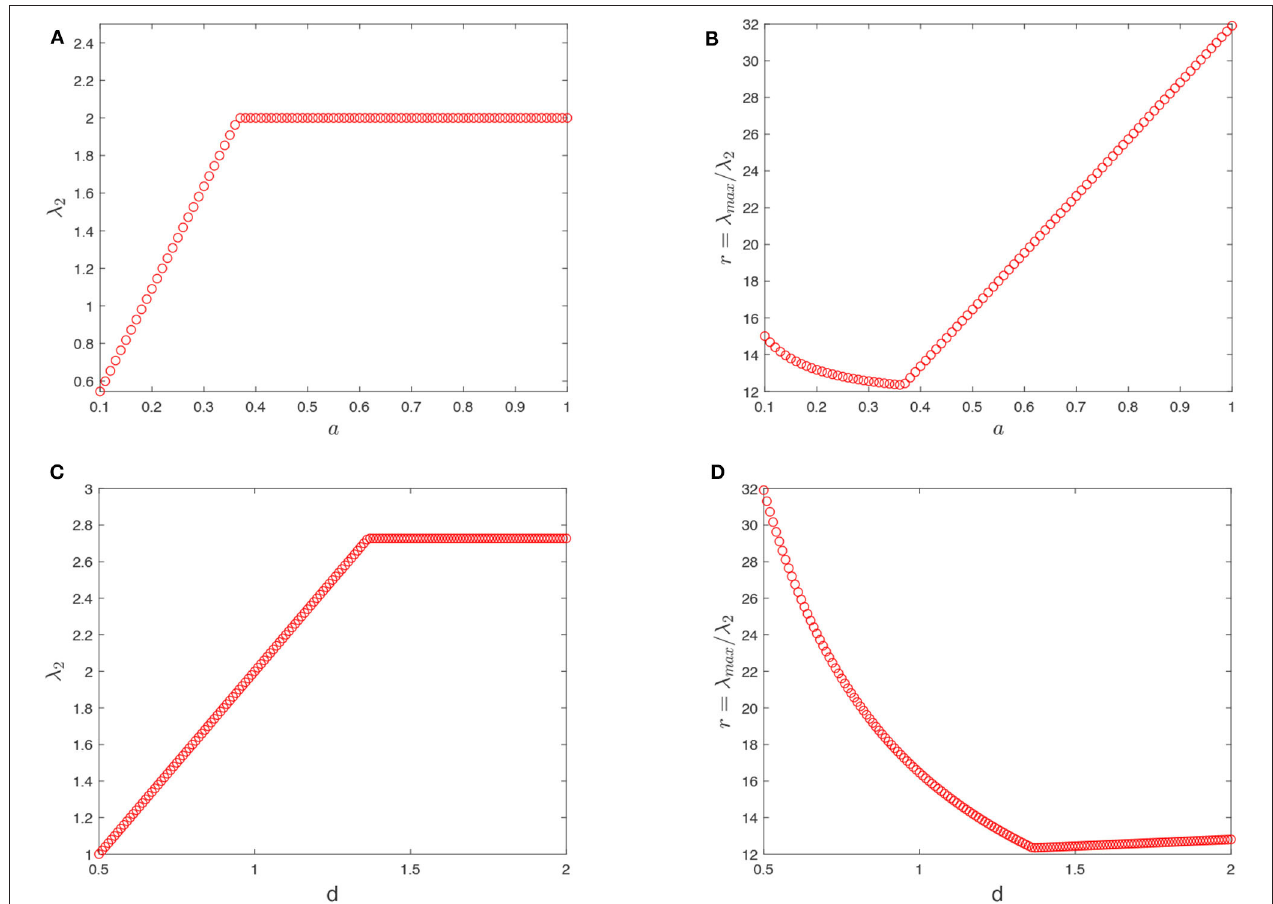
FIGURE 2 | Synchronizability of two-layer K-nearest-neighbor networks. Panels (A,B) display λ 2 and r = λ max /λ 2 vs. the intra-layer coupling strength a ( N = 200, K = 50, d = 1). Panels (C,D) display λ 2 and r = λ max /λ 2 vs. the inter-layer coupling strength d ( N = 200, K = 50, a =